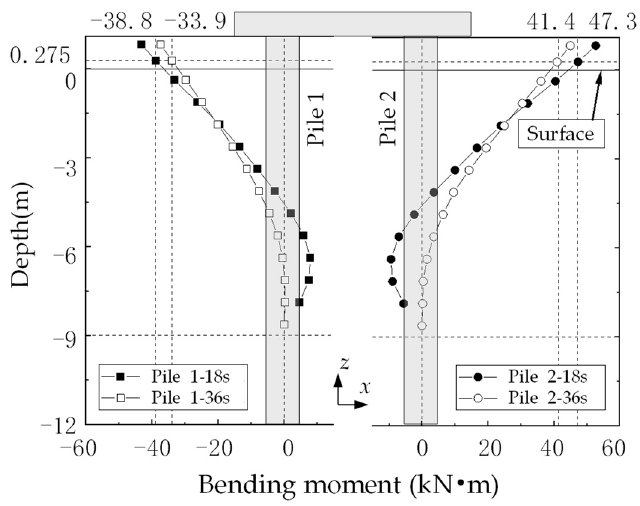
Figure 21. Bending moment of Pile 1 and Pile 2 at 18 s and 36 s.